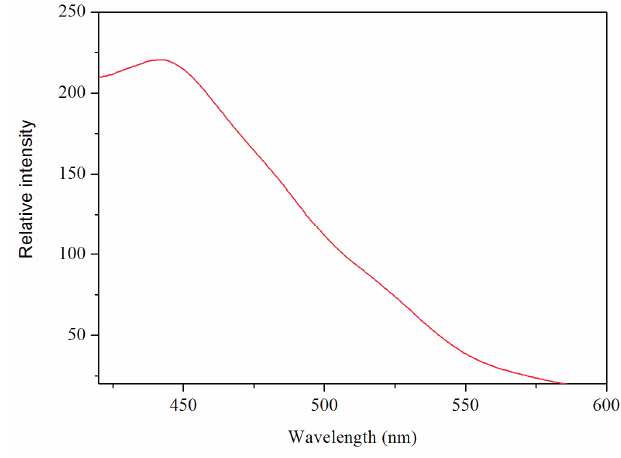
Figure 6. Luminescent spectrum of complex 1